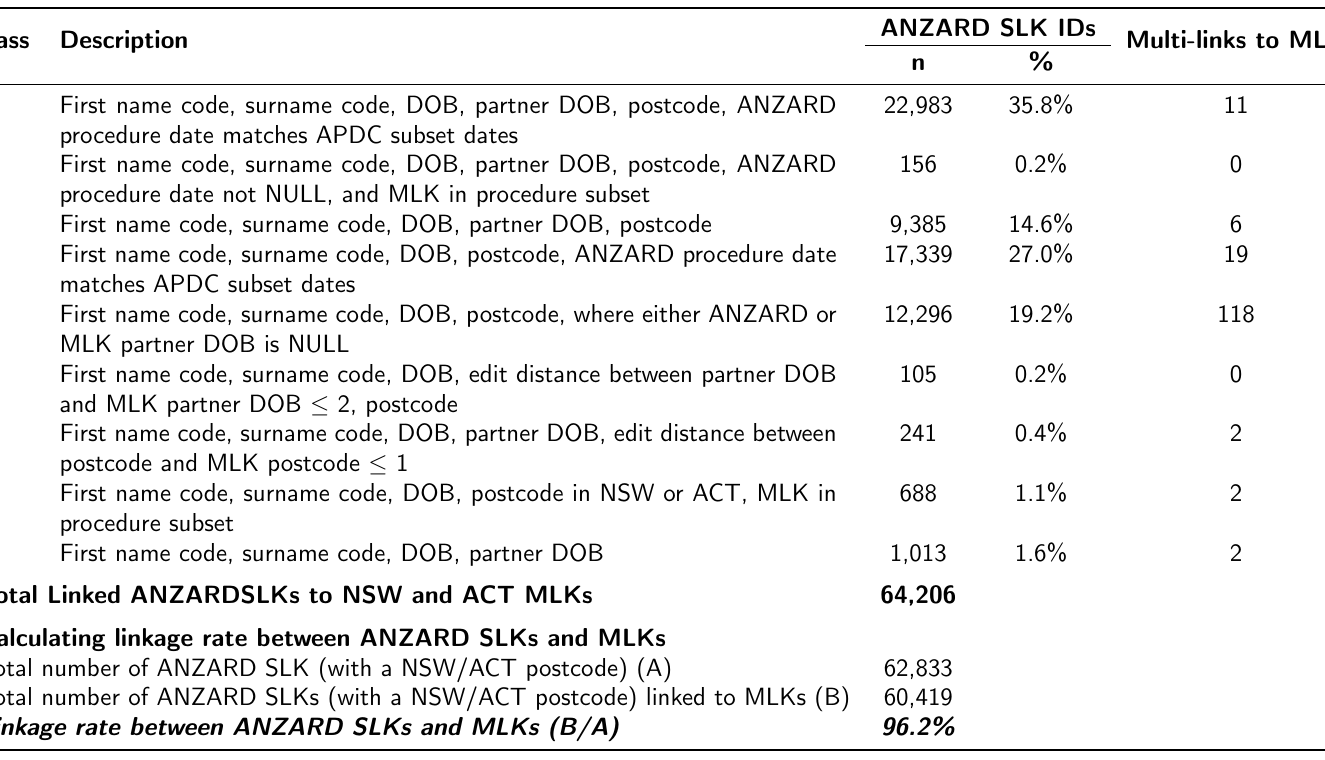
Table 2: Linkage results for the data linkage between ANZARD statistical linkage key (SLKs) and New South Wales (NSW) and Australian capital territory (ACT) master linkage key (MLKs), number and percentage of total linked